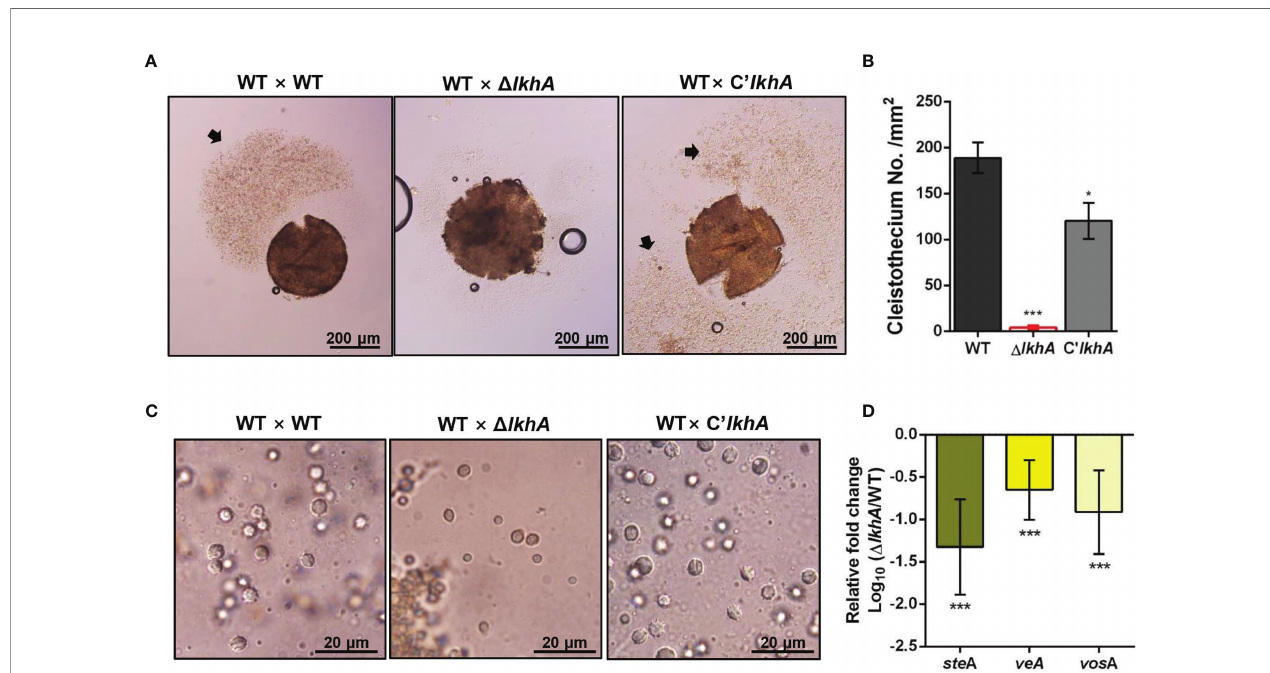
FIGURE 2 | Role of Af LkhA in sexual development. (A) Morphology of the sexual fruiting body, cleistothecium, in WT, D A fl khA , and C ’ A fl khA strains. Mycelial balls were moved to oatmeal agar and incubated at 30°C for 14 days under dark conditions to induce sexual development. Arrow indicates a cloud of ascospores sprayed from cleistothecium. (B) Quanti fi cation of cleistothecia production (n = 5). Asterisk represents signi fi cant differences: *P < 0.05, ***P < 0.001. (C) Morphology of ascospores. Cleistothecium was ruptured on a glass slide to observe ascospores. (D) Relative expression patterns of steA , veA and vosA . Total RNA was extracted from cleistothecia. RT-qPCR analysis was performed using 18S rRNA gene as an internal control. The x-axis shows a list of genes. The y-axis indicate the relative mRNA abundance of the genes in D A fl khA strain compared to WT. The values were transformed and presented as Log 10 . ***P <